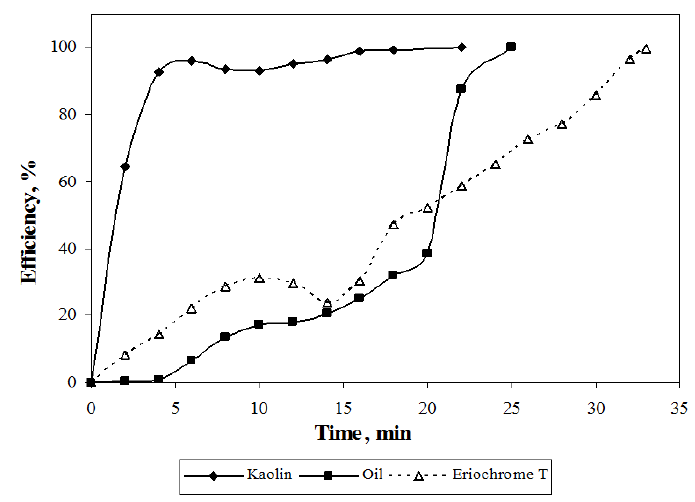
Figure 6. The variation of efficiency with time, in optimal working conditions, for the three pollutant compounds. Table 2. The optimized conditions for a maximum efficiency obtained through ANN-GA